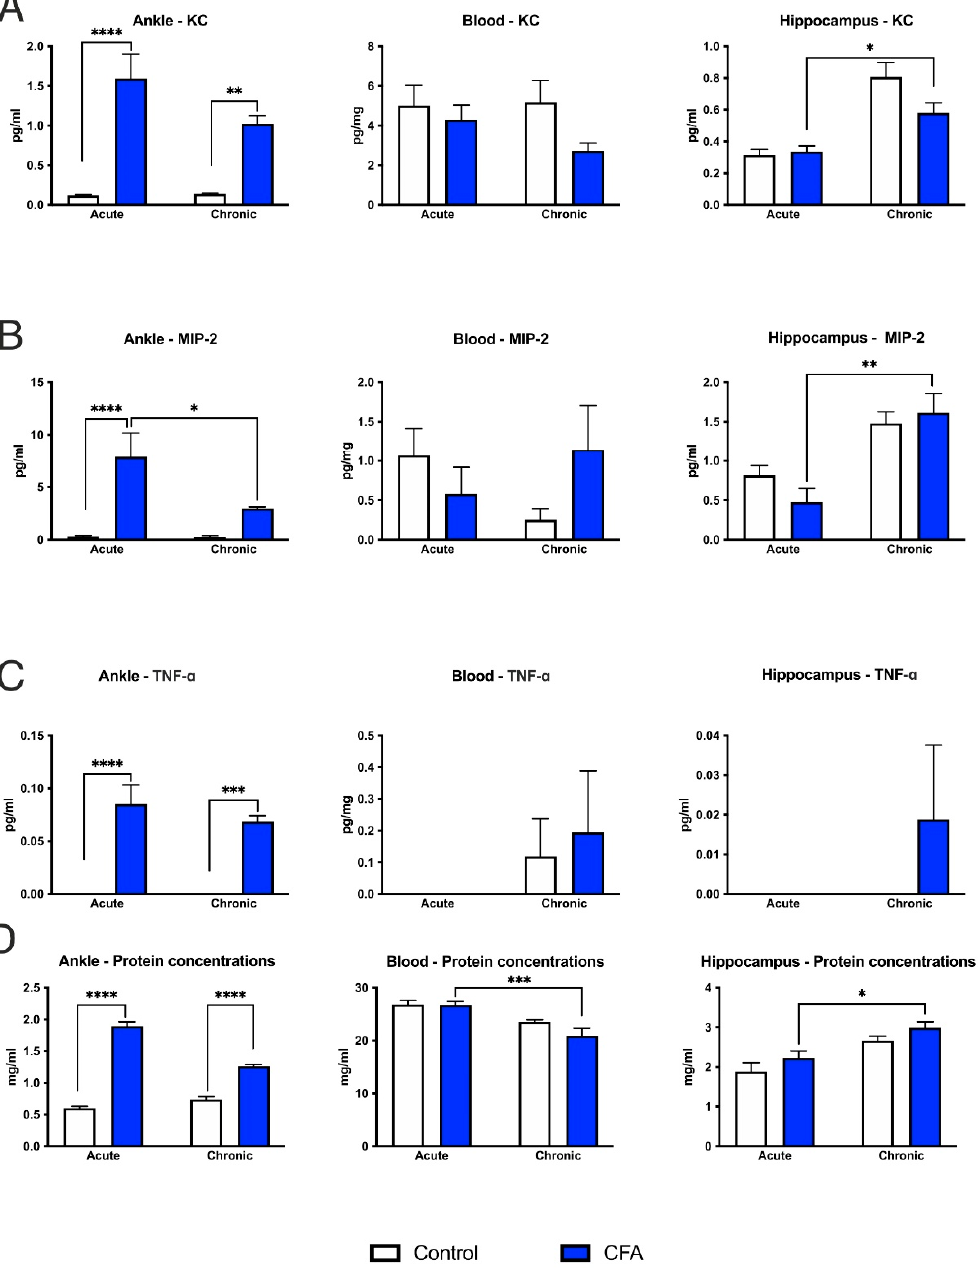
Figure 10. Cytokine/chemokine and total protein concentrations in the CFA-treated hind paws, pe- ripheral blood and hippocampus. ( A – C ) In the hind paws, acute inflammation increased cytokine concentrations of KC, MIP-2 and TNF- α , whereas chronic arthritis increased KC and TNF- α levels. In the peripheral blood, we found no change in these cytokine levels. In the hippocampus, CFA treatment did not alter any cytokine levels compared to the corresponding control groups. ( D ) Both acute and chronic inflammation increased total protein concentrations in the joints, and a similar trend was present in the hippocampus. On some graphs, there are no bars, which means that those cytokine concentrations were below the detection levels. Statistics: two-way ANOVA (CFA treat- ment × time) followed by Tukey’s multiple comparisons post hoc test. * p < 0.05; ** p < 0.01; *** p < 0.001; **** p < 0.0001. Abbreviations: complete Freund’s adjuvant (CFA); keratinocyte-derived chem- okine (KC); macrophage inflammatory protein-2 (MIP-2); tumor necrosis factor alpha (TNF- α ). 4. Discussion Here, we report that chronic CFA-induced arthritis can inhibit neurogenesis in the adult hippocampus. Adult neurogenesis is a complex, multistep process, which involves cell proliferation, cell differentiation and maturation, as well as the integration of newborn neurons into the pre-existing circuit [62]. In the present experiment, cell proliferation (i.e., the number of BrdU+ cells) was not influenced by the peripheral inflammation, and the survival of newborn neurons (i.e., the number of DCX cells) was reduced in the CFA- treated animals. In other words, the CFA-induced changes in neurogenesis occurred dur- ing the early maturation phase of the newborn neurons, rather than during the prolifera- tion phase. In our CFA-induced experimental arthritis model, we found clear molecular, cellular and behavioral evidence of the acute and chronic peripheral inflammation in the hind paws. In the acute inflammatory phase, the blood cell count data suggested a more gen- eralized, systemic inflammatory reaction, but this was not reflected in the cytokine/chem- okine levels of the peripheral blood, except for IL-6, which increased. In the chronic phase, we found no evidence of a systemic inflammatory reaction in blood cell numbers or serum cytokine/chemokine concentrations. In the hippocampus, we found no change in the cy- tokine/chemokine levels, and the Iba1-positive microglia numbers also remained unal- tered both in the acute and chronic inflammatory phase. However, we found a signifi- cantly increased density of the CD68-positive macrophages/activated microglia in the dentate gyrus of the CFA-treated mice, both in the acute and chronic inflammatory phases. Overall, these data suggest that acute peripheral inflammation initiates a cascade of molecular and cellular changes that eventually leads to reduced adult neurogenesis in the dentate gyrus since essentially all of the inflammatory reactions that we could detect in the blood were present only in the early phase of inflammation. Previous studies reported controversial findings regarding the effect of peripheral inflammation on adult hippocampal neurogenesis. Data from experimental colitis models documented either inhibition of adult neurogenesis [30,31] or normal levels with deficits in the migration and integration of newborn neurons in the functional circuitry of the dentate gyrus [32], whereas experimental arthritis models reported either a transient in- crease in hippocampal precursor cell proliferation and neurogenesis [33] or no effect [34].